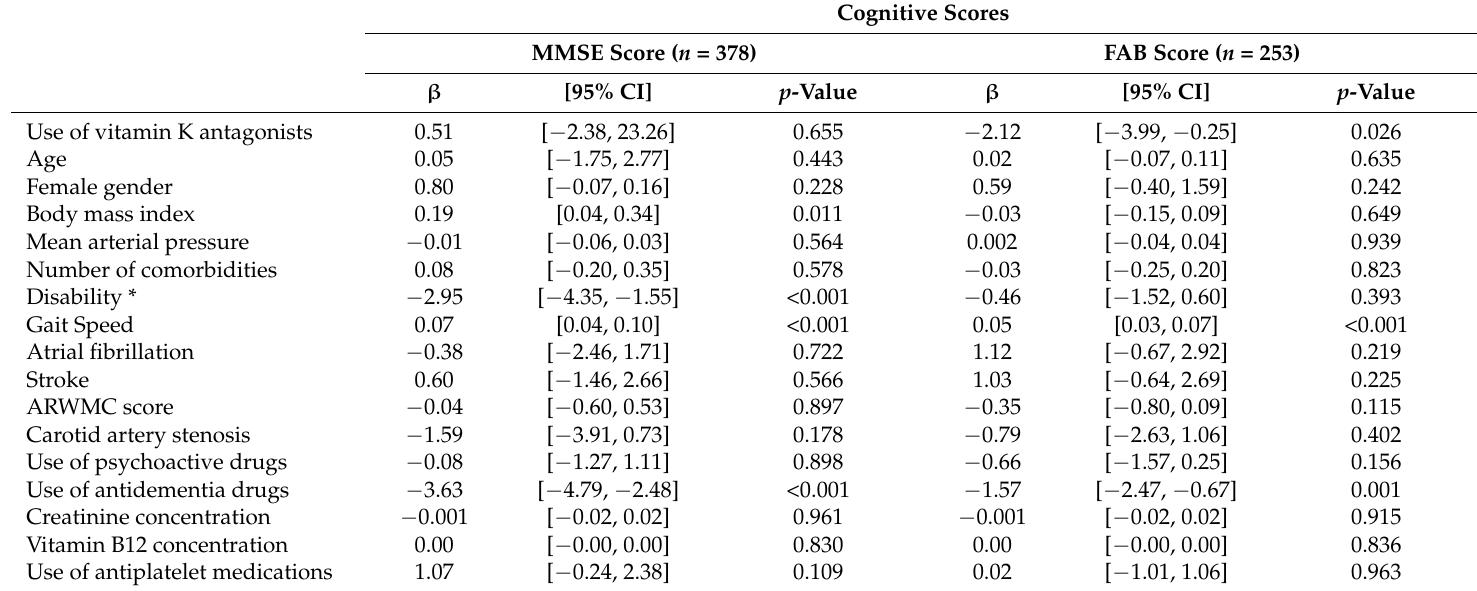
Use of psychoactive drugs − 0.08 Use of antidementia drugs − 3.63 [ − 4.79, − 2.48] Creatinine concentration − 0.001 Vitamin B12 concentration 0.00 [ − 0.00, 0.00] [ − 0.00, 0.00] 0.836 Use of antiplatelet medications 1.07 [ − 0.24, 2.38] 0.109 0.02 [ − 1.01, 1.06]